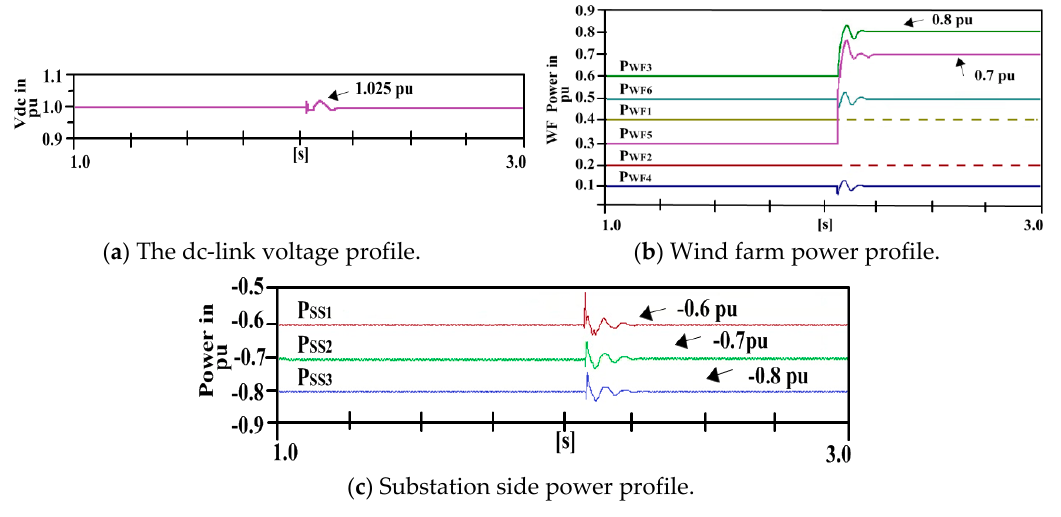
Figure 14. Permanent dc line–line fault F 1 on cable L 12 .